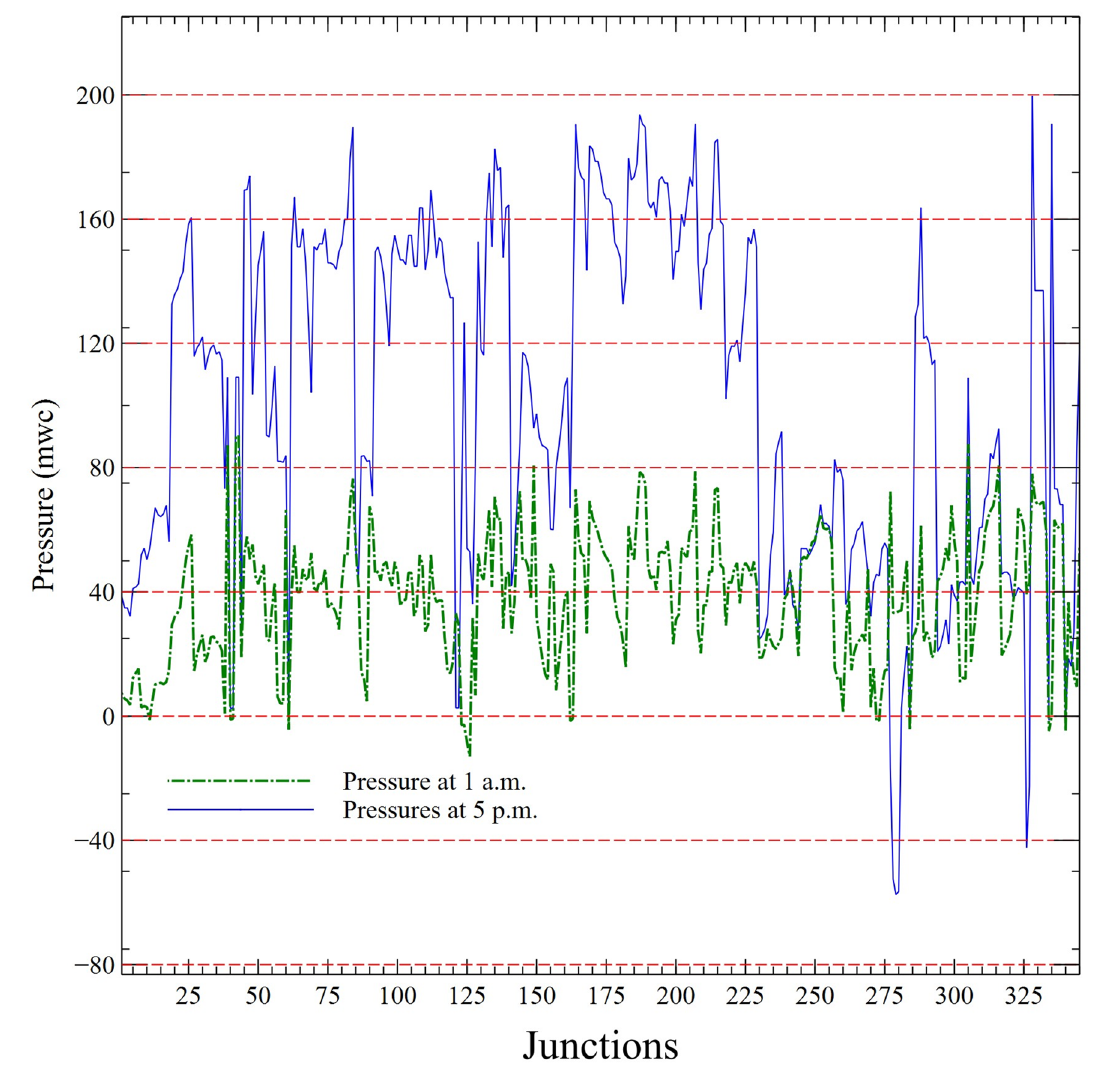
Fig. 8 Pressure fluctuations in the Goma's water supply network